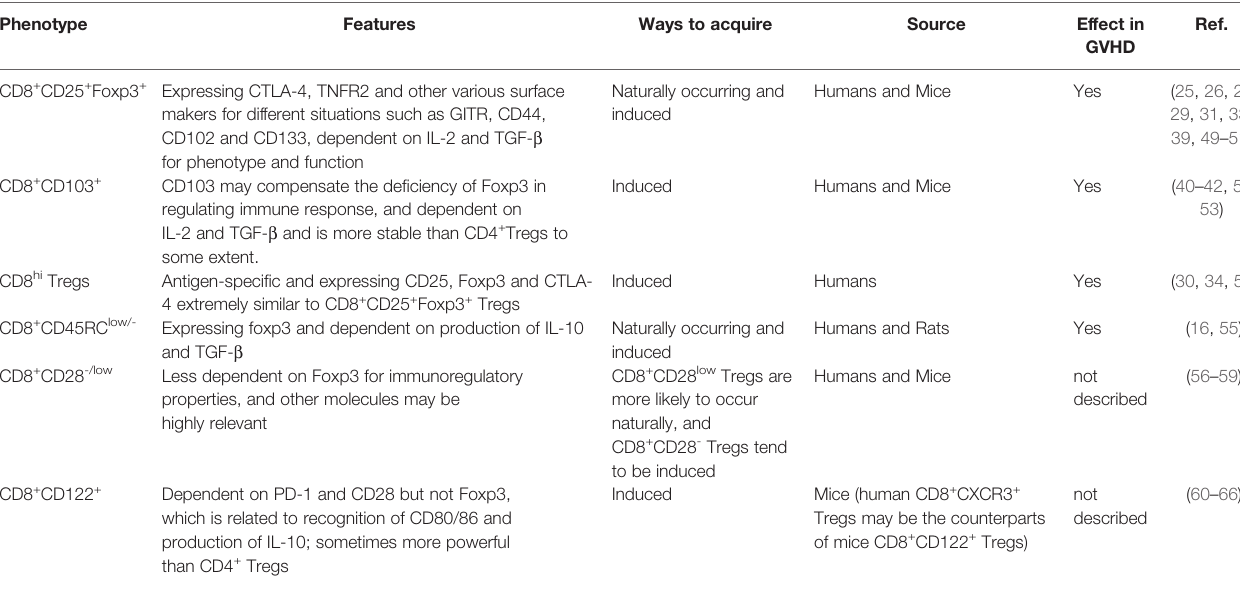
TABLE 1 | Heterogeneity of CD8 +